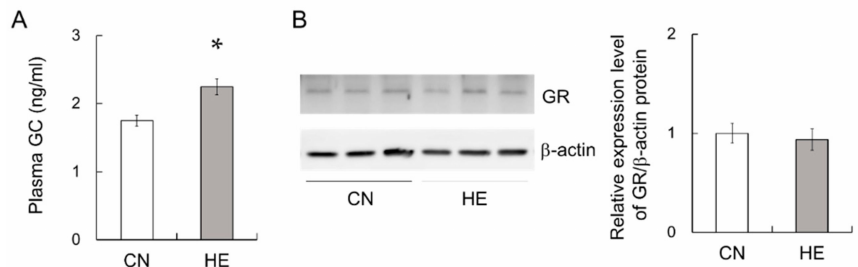
Figure 5. Plasma glucocorticoid (GC) level and glucocorticoid receptor (GR) expression in the submandibular glands (SMGs) of control (CN) and heat-exposed (HE) rats. ( A ) Plasma GC level in the CN and HE groups. Heat exposure significantly increased the plasma GC level in the rats. ( B ) GR protein expression in the SMGs. Heat exposure did not change GR protein expression level in the SMGs. Left 3 lanes show CN rats, and right 3 lanes show HE rats. * p < 0.05, significant di ff erence between the CN and HE groups. Values are presented as the mean ± SEM ( n = 8 in each